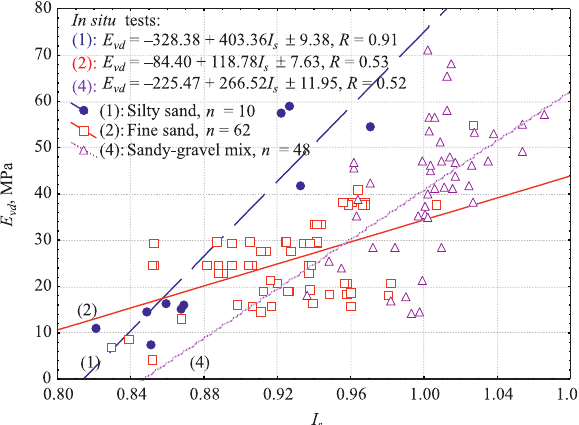
Fig. 4. Dependence E vd = f ( I s ) for data from in situ tests: (1) – silty sand; (2) – fine sand; (4) – sandy-gravel mix than for relationships (3) or (4) for medium sand or sandy- gravel mix. As an example, for fine sand at I = 1, Eq (2) in s Fig. 5 leads to E = 49.02 ± 5.59 MPa which results in a vd relative error of about